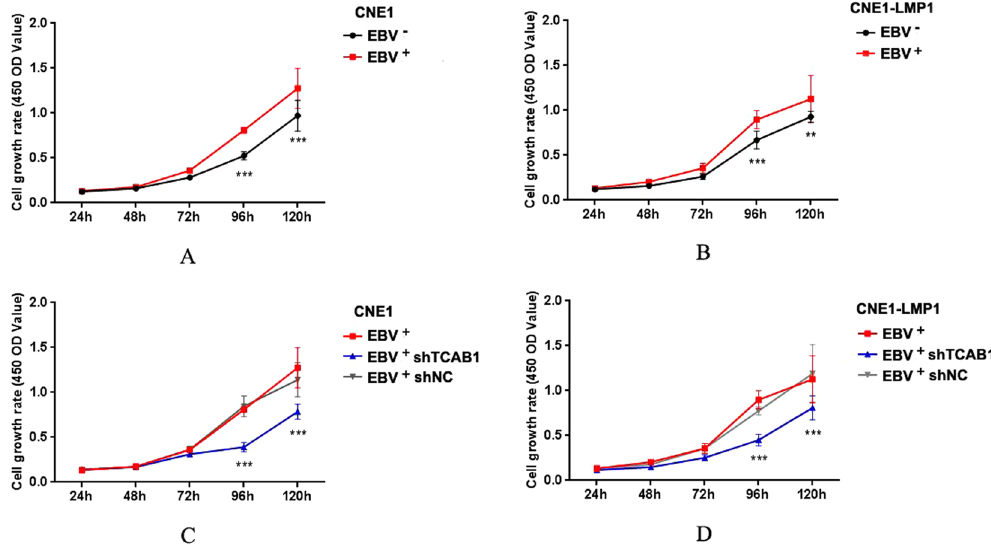
Figure 4. Depletion of TCAB1 reduces the proliferation of EBV-positive cells in vitro . ( A ) EBV promoted proliferation in CNE1 cells. ( B ) EBV promoted proliferation in CNE1-LMP1 cells. ( C ) Depletion of TCAB1 by exogenous shRNA lentivirus decreased proliferation in CNE1 cells infected with EBV. ( D ) Depletion of TCAB1 reduced proliferation in CNE1-LMP1 cells infected with EBV. The statistical analysis was performed using